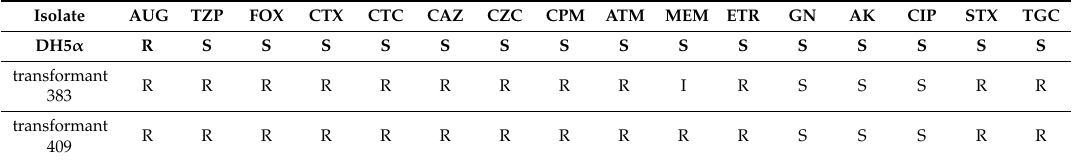
Table 1. Comparison of antimicrobial susceptibilities between E. coli DH5 α and two transformants. Isolate